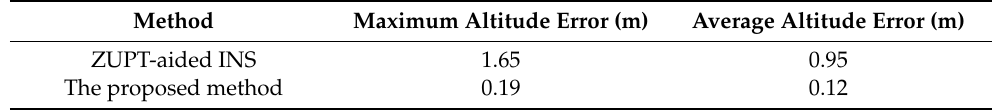
Table 5. Altitude error of different methods.